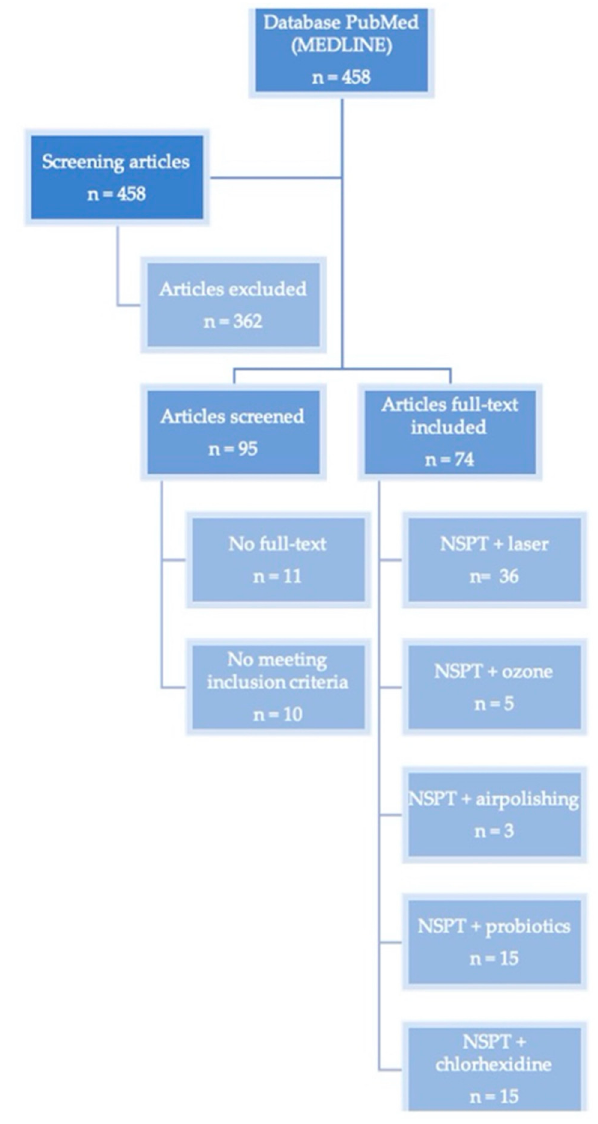
Figure 2. Articles included in the present investigation. NSPT: nonsurgical periodontal therapy.